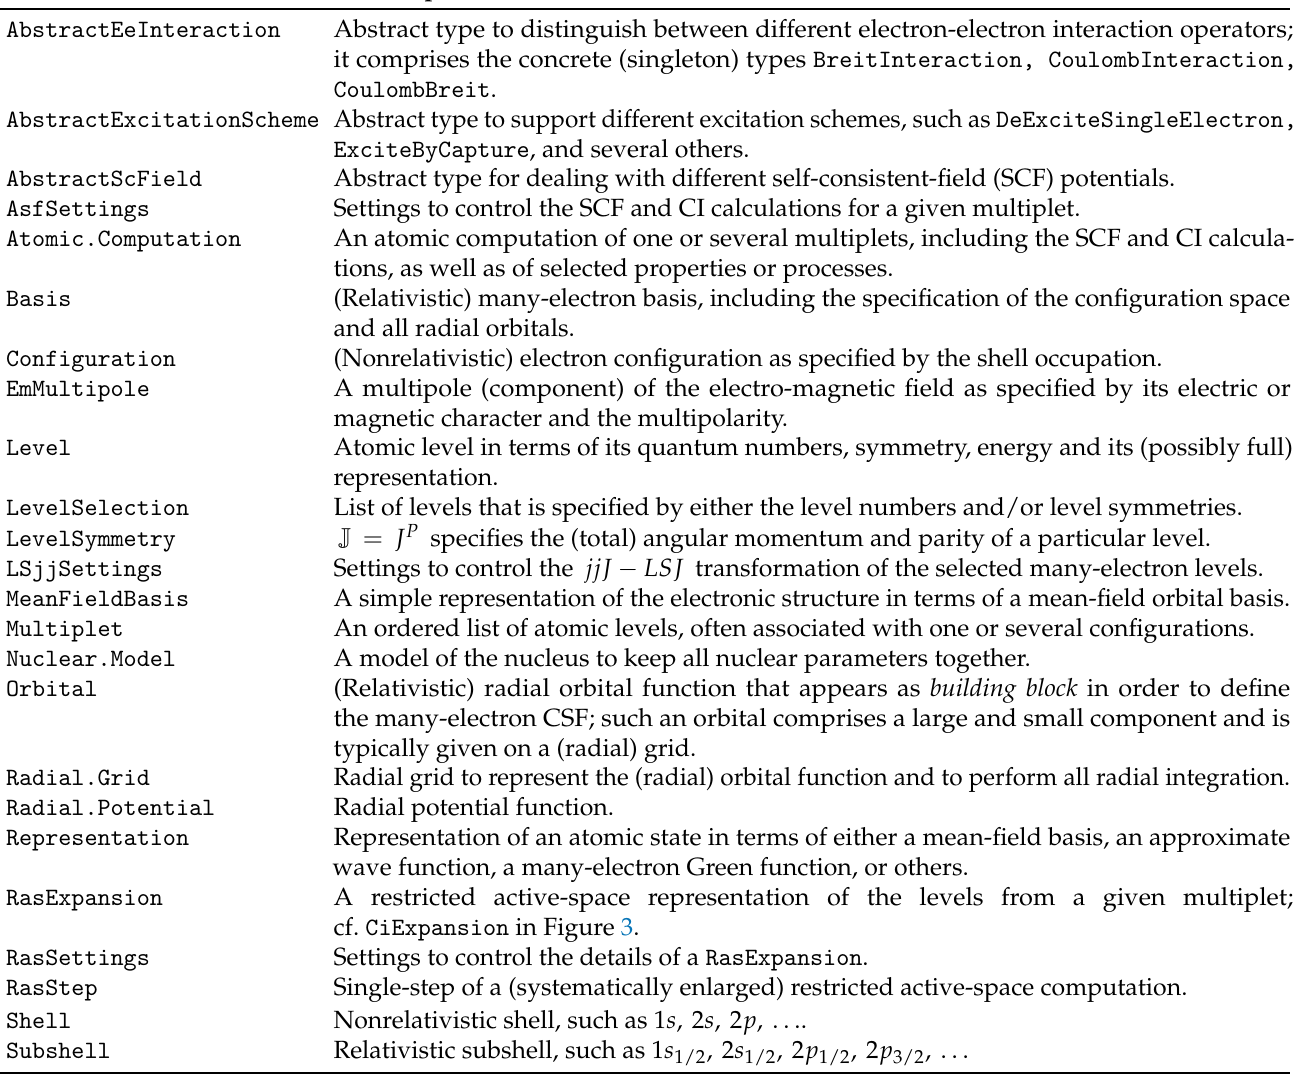
Table 1. Selected data types of the J AC toolbox for predicting the properties of open d - and f -shell elements. Here, only a brief explanation is given, while further details can be found at Julia’s REPL [50] by typing, for instance, ? Representation